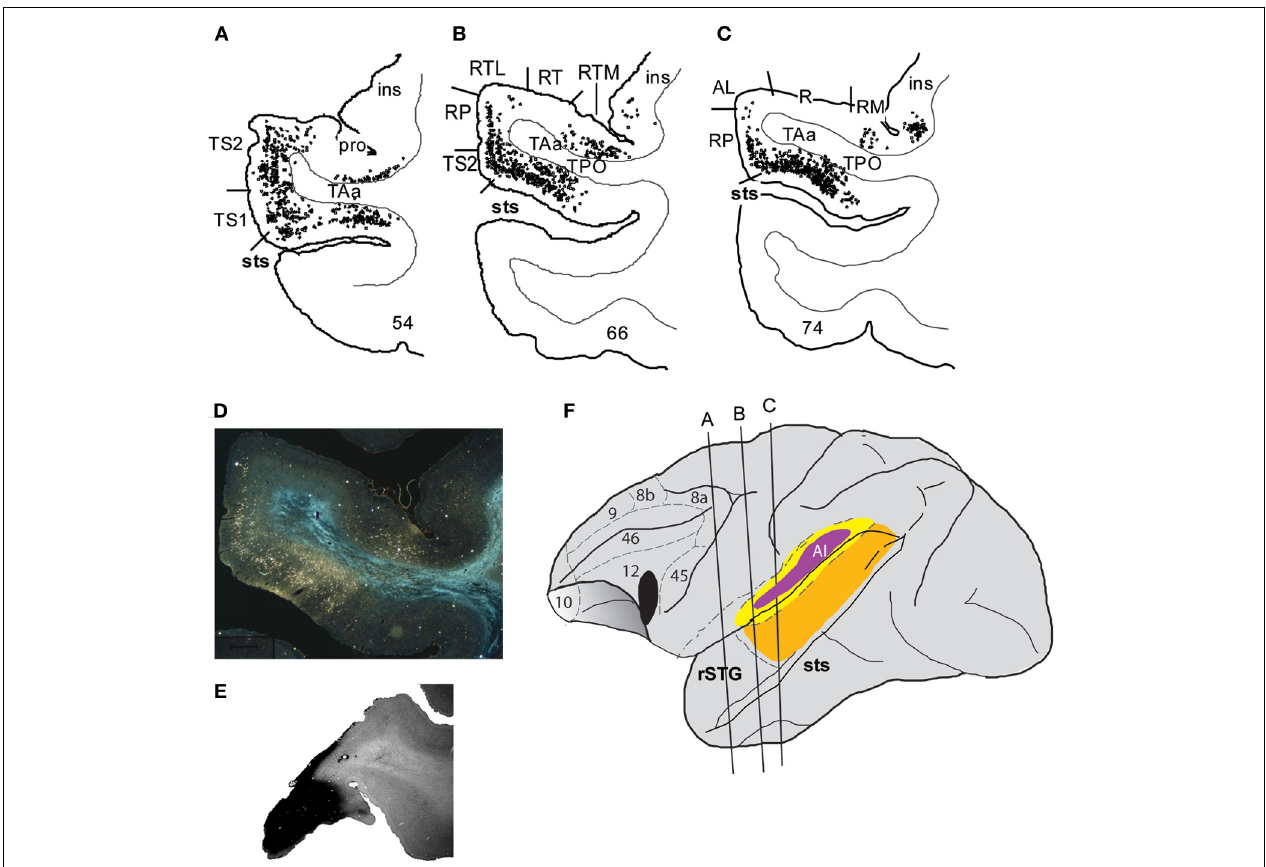
FIGURE 2 | Connections of VLPFC with auditory cortex. An injection of WGA-HRP shown previously (Romanski et al., 1999a) illustrates the density of connections of VLPFC with auditory cortical regions in the belt, parabelt and superior temporal sulcus as well as the rostral temporal lobe. Coronal sections through the temporal lobe are shown in (A–C) with black dots illustrating the location of retrogradely labeled cells. Labeling is heaviest in the superior temporal sulcus regions TPO and TAa, moderate in the parabelt